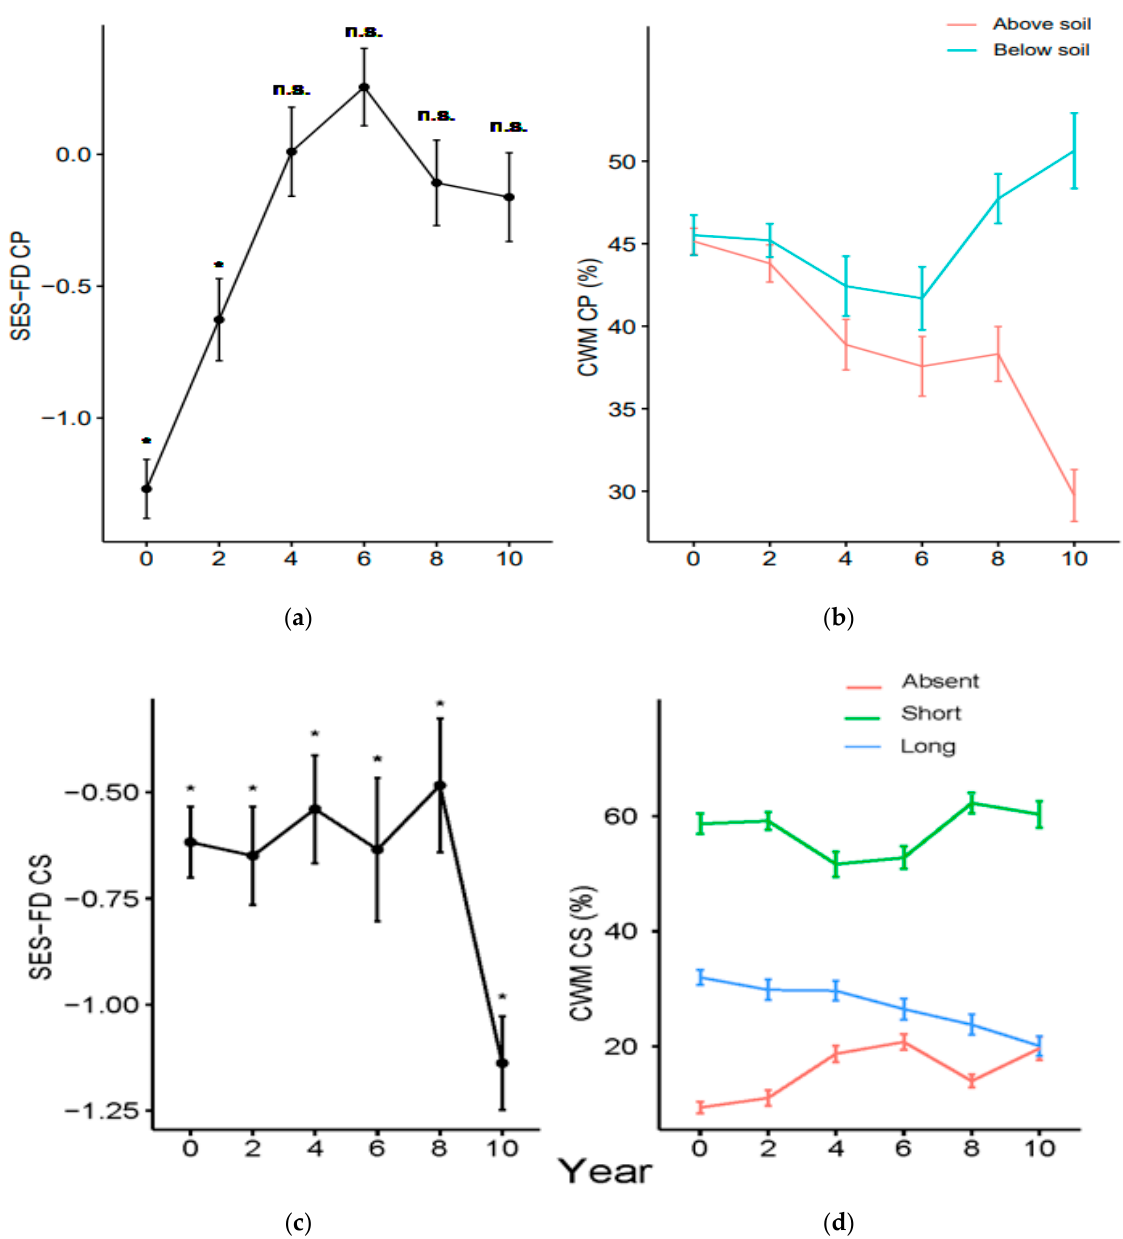
Figure 5. Trends of standardized effect size of functional diversity (SES-FD) and community weighted means (CWMs) (mean ± s.e.) for ( a , b ) clonal spread (CS), ( c , d ) clonal position (CP) under twice-a-year mowing. Year 0 (before treatment) refers to 2010; years 2, 4, 6, 8, and 10 correspond to 2012, 2014, 2016, 2018, and 2020. The asterisk ( * ) and n.s. indicate whether the distribution of SES-FD is significantly or not significantly different from zero after a one-sample two-tailed t -test ( p < 0.05).